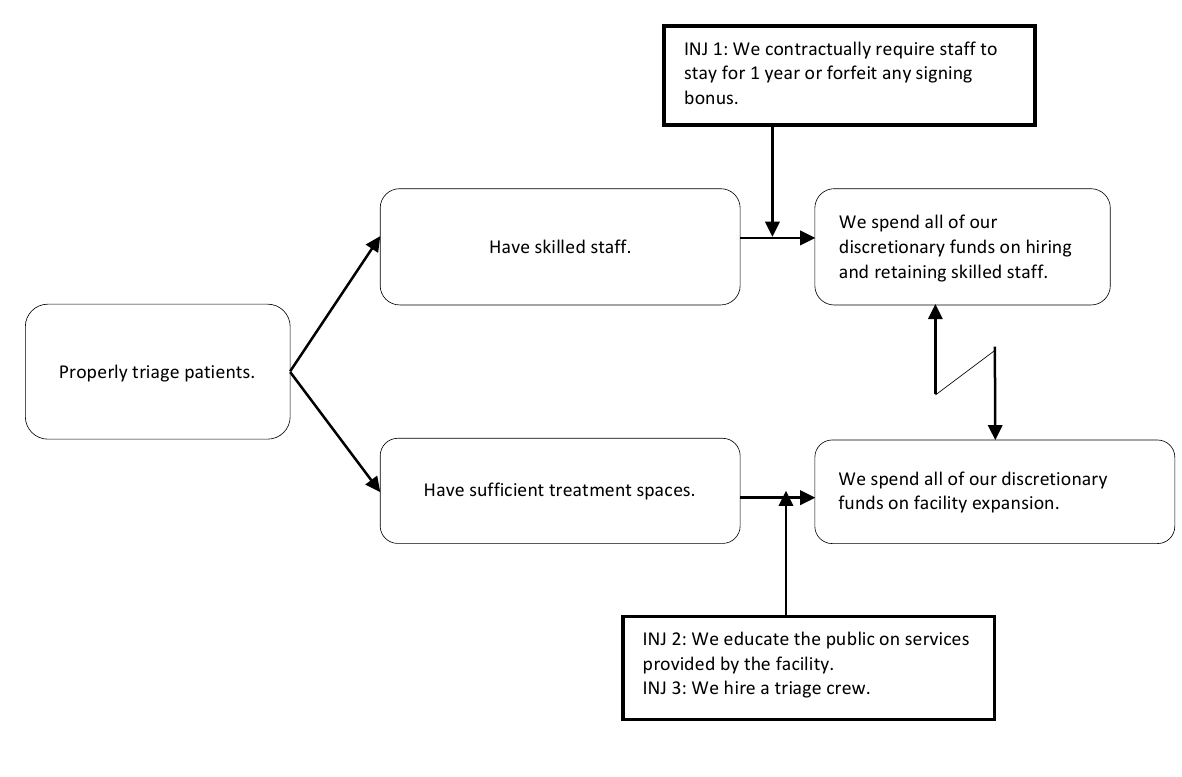
Figure 3 . Evaporative Cloud with Injections of Goldratt’s Theory Applied to the Problems Associated with an Emergency Department at a